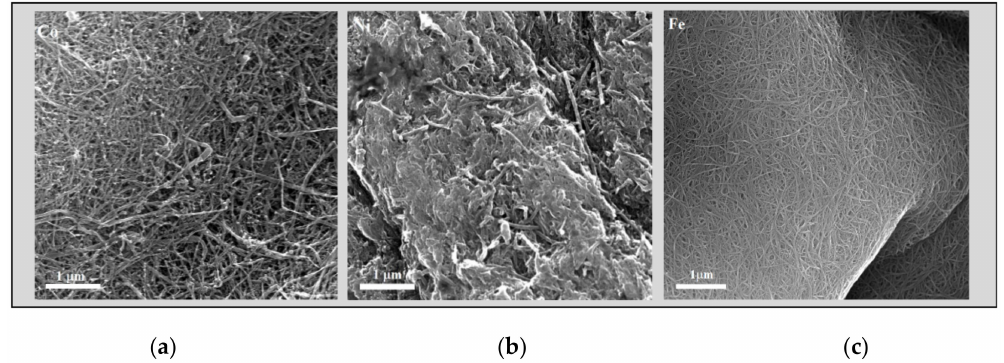
Figure 6. SEM images of the carbon nanotubes synthesized over di ff erent metallocenes: ( a ) cobaltocene; ( b ) nickelocene; ( c ) ferrocene.